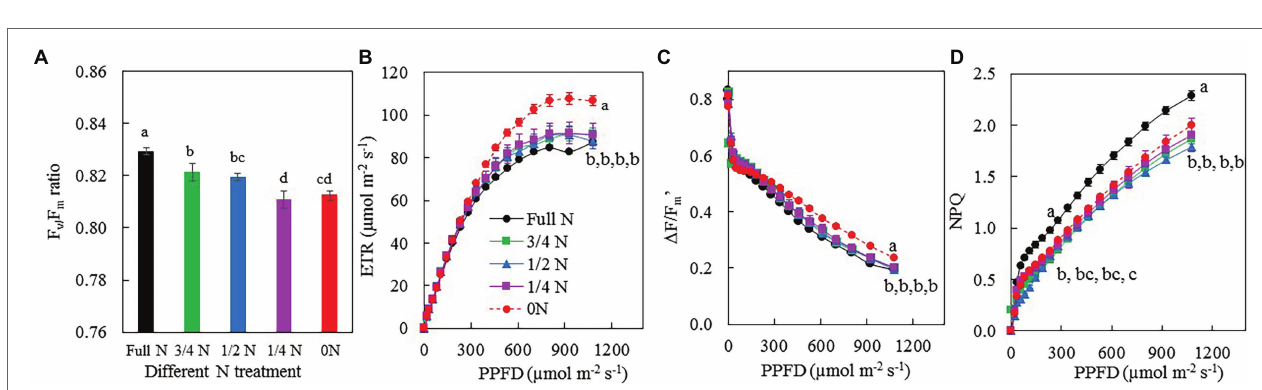
FIGURE 6 | F v /F m ratio (A) , light-response curves of electron transport rate (ETR; B ), Δ F/F m ' (C) , and NQP (D) of M. crystallinum after 7 days of different NO 3– treatments. Vertical bars represent the SEs. Means with different letters are statistically different ( p = 0.05; n = 4) as determined by LSD multiple comparison